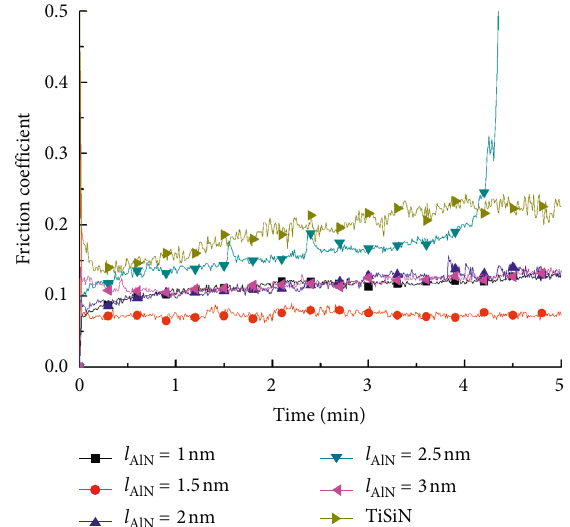
Figure 5: Friction coefficient of TiSiN/AlN nanomultilayers with different thicknesses of AlN layer and monolithic TiSiN